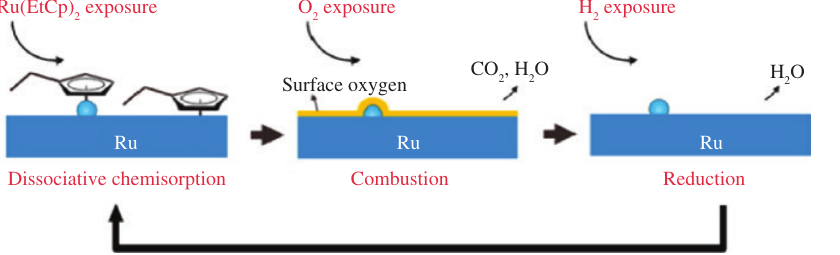
-O -H on a Ru metal surface. Reprinted with permission from 2 2 2